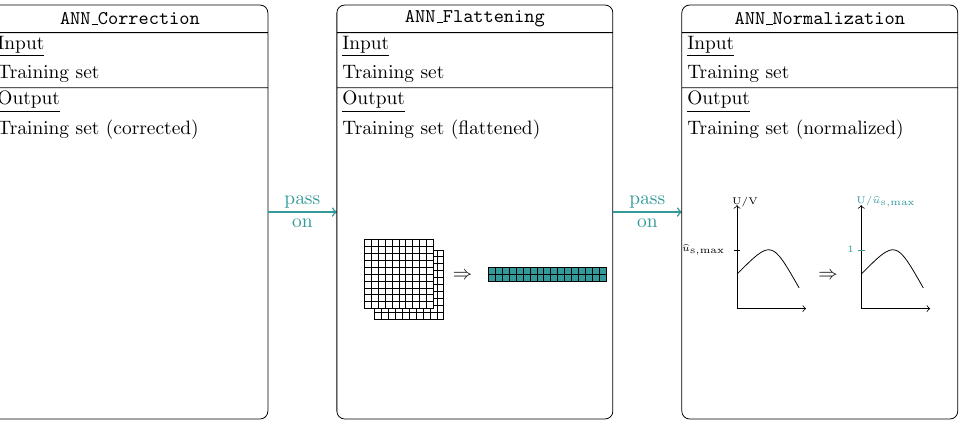
Figure 14. Illustration of the workflow of the data preprocessing. The subroutine ANN_Correction removes and corrects erroneous data entries. After that the subroutine ANN_Flattening adjusts the data dimensions to the input dimensions 4 in (14) and 2 in (15) for the considered case). This of the neural network (recall x y R R ∈ ∈ is required as the data set creation provides data with the (cid:98)